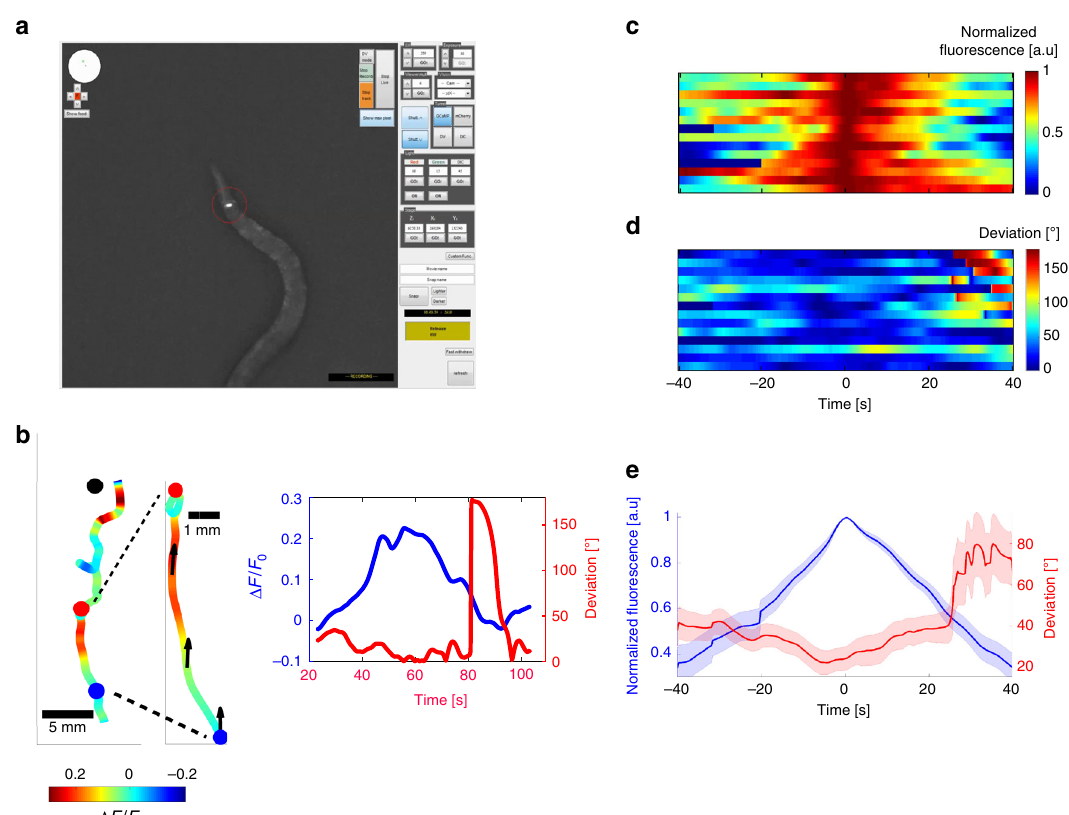
Fig. 2 The pulsatile activity dictates behavioral outputs. a We developed an automated tracking system that enables tracking of worm movement while simultaneously measuring neural activity from a single neuron. Shown is a screenshot taken from the system as it tracked animal trajectory and AWA activity (red circle) during chemotaxis. b Left part is an example of a worm trajectory from its starting position to the target (diacetyl spot, black dot). The color code represents neural activity levels. In the middle, the trajectory zoom-in demonstrates a single pulse in which activity rose and dropped even when the animal was well directed toward the target (indicated by black arrows). This recapitulates the data observed using the micro fl uidic device, where activity increased and decreased despite continuously increasing gradients. Right graph extracts from the zoomed trajectory the fold-change activity in AWA (blue) and the angular deviation (red) between the velocity vector and the direct path to the target (as denoted by black arrows on the trajectory). Small deviations indicate that the worm is well oriented toward the target, and ~180° deviation indicates a movement in the opposite direction. An abrupt increase in deviation indicates a reversal event. This demonstrates that animals reverse after AWA crosses peak activity, during the decreasing phase of the pulse. c AWA activity measured from freely-chemotaxing worms ( N = 14). The fi rst pulse of AWA was aligned to the point of maximal activity. The fi rst trace belongs to the worm plotted in b. d The angular deviation corresponding to the neural activation shown in c . All reversal events appeared after AWA crossed its peak activity, suggesting it is the decrease in AWA activity that promotes turns, and not vice versa. Maximal deviation is signi fi cantly higher in the second half of the pulse, during its decreasing phase (Wilcoxon rank-sum test, p = 0.0035). e Mean normalized intensity (blue) and angular deviation (red) of the 14 worms in c , d . Shaded colors mark the standard